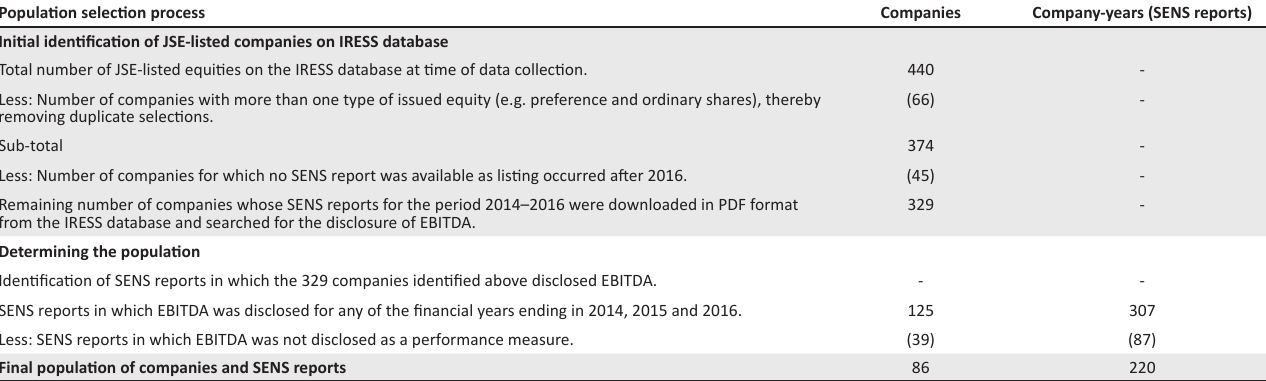
TABLE 1: Determining the population of SENS reports containing earnings before interest, tax, depreciation and amortisation as a performance measure. Population selection